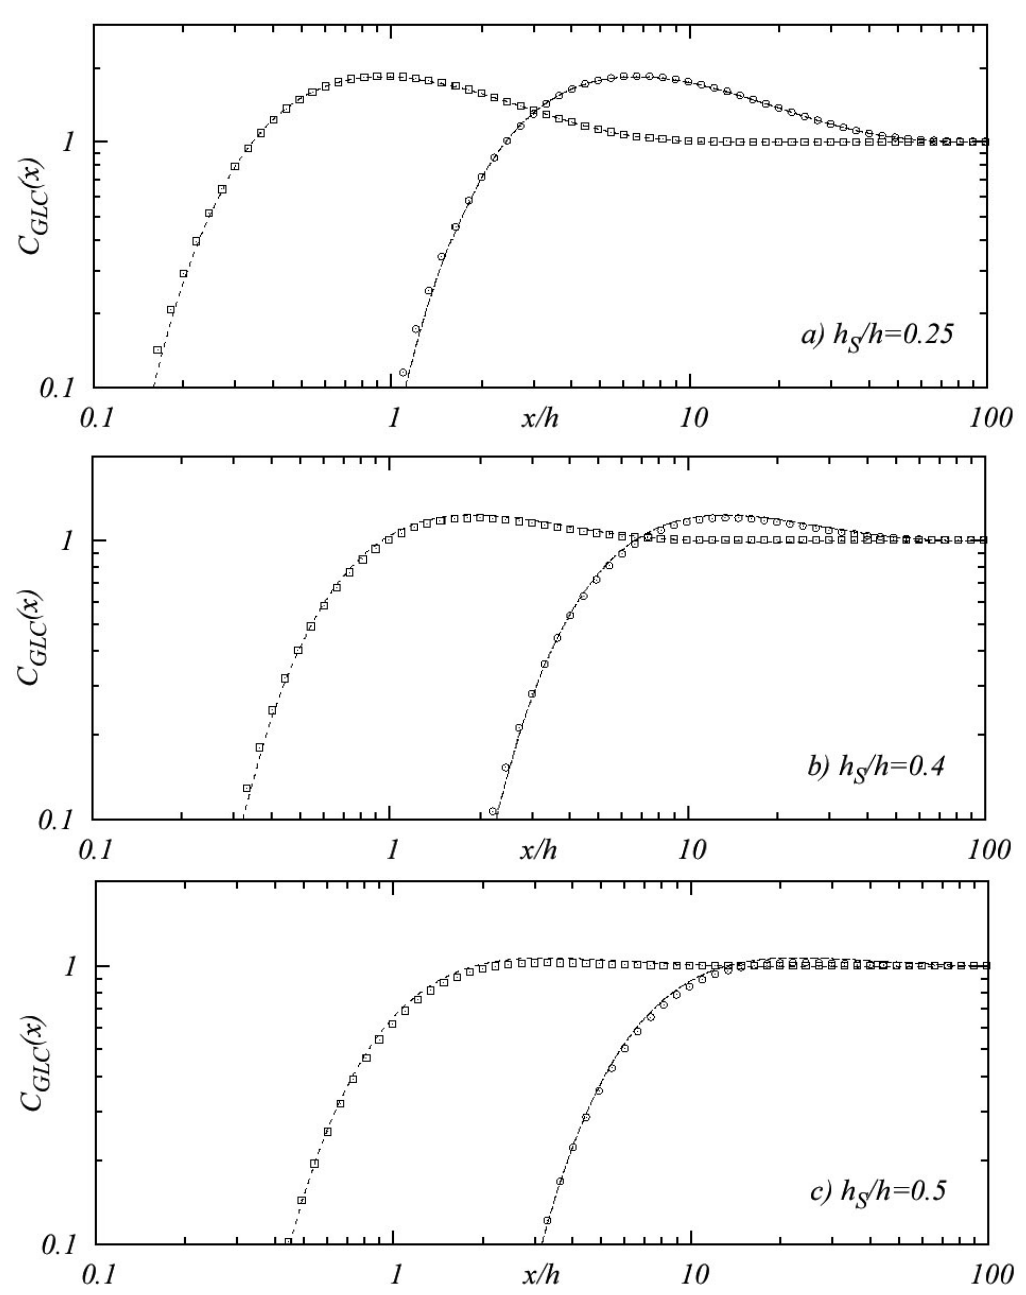
25.0~ 4.0~ 5.0~ ~ h , ( b ) h , and ( c ) h . Points refer to for ( a )    s s s 001.0~ 099.0~ L , empty circles L   MO MO